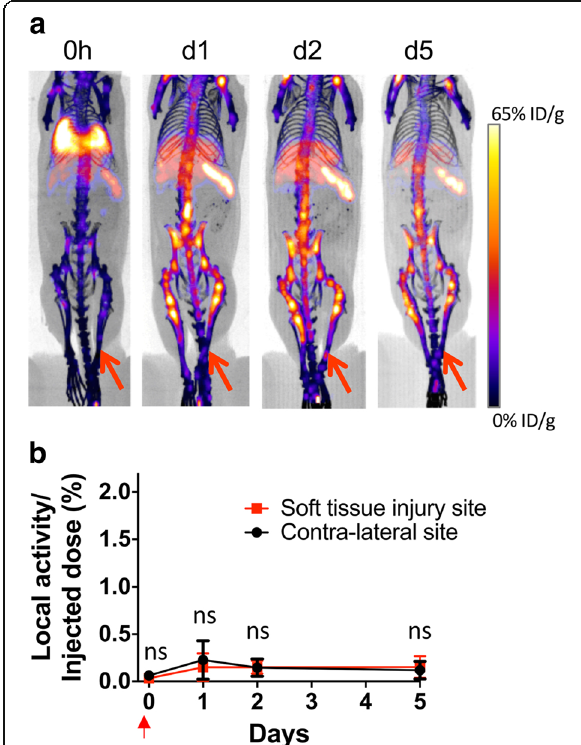
Fig. 4 Soft-tissue injury does not attract the BM cells. a A soft-tissue injury in the distal lower leg overlying the distal tibia was created and 89 Zr-labeled BM cells (2 × 10 7 cells at 9.65 – 21.3 kBq/10 6 cells) were transferred intravenously. MicroPET/CT images were acquired on days 0, 1, 2, and 5 ( n = 4). b Soft-tissue incision without bone fracture did not recruit BM cells to the injury site. The arrow indicates the timing of soft-tissue injury